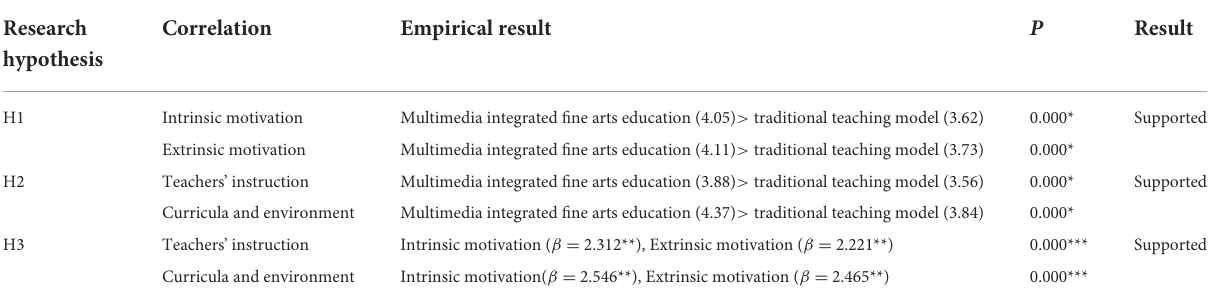
TABLE 4 Hypothesis